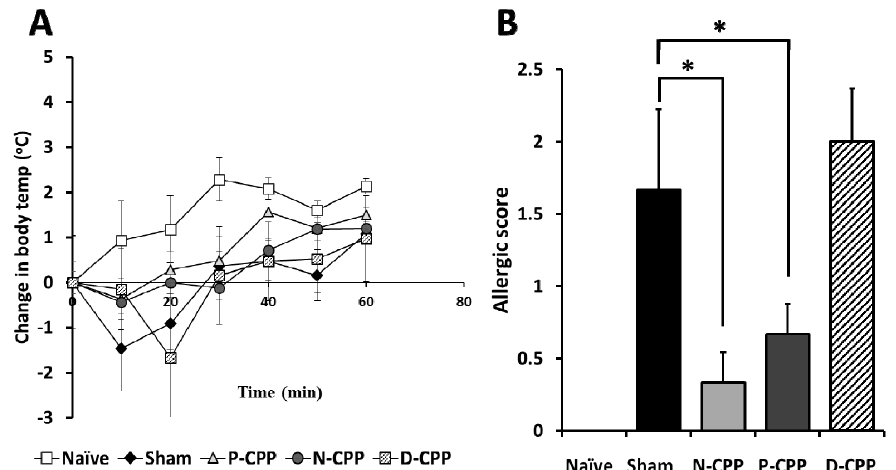
Figure 2. Effects of oral feeding with differently phosphorylated CPP-III on body temperature and allergic score following oral challenge with OVA in OVA-sensitized mice. OVA-sensitized mice were fed differently phosphorylated CPP-III for a period of 6 weeks, and the body temperature ( A ) and allergic score ( B ) were determined in the oral challenge test. Body temperature changes were recorded at 0, 10, 20, 30, 40, 50, and 60 min, while allergic scores and anaphylactic symptoms were evaluated and scored from 40–90 min after oral challenge. Data represent the mean ± standard error (SE) of individual mice in the group. * p <